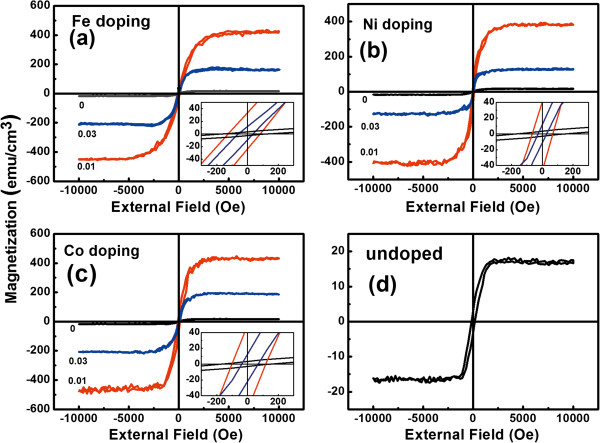
M-H curves of TM-doped TiO2 films. (a) Fe doping. (b) Ni doping. (c) Co doping. (d) Undoped.